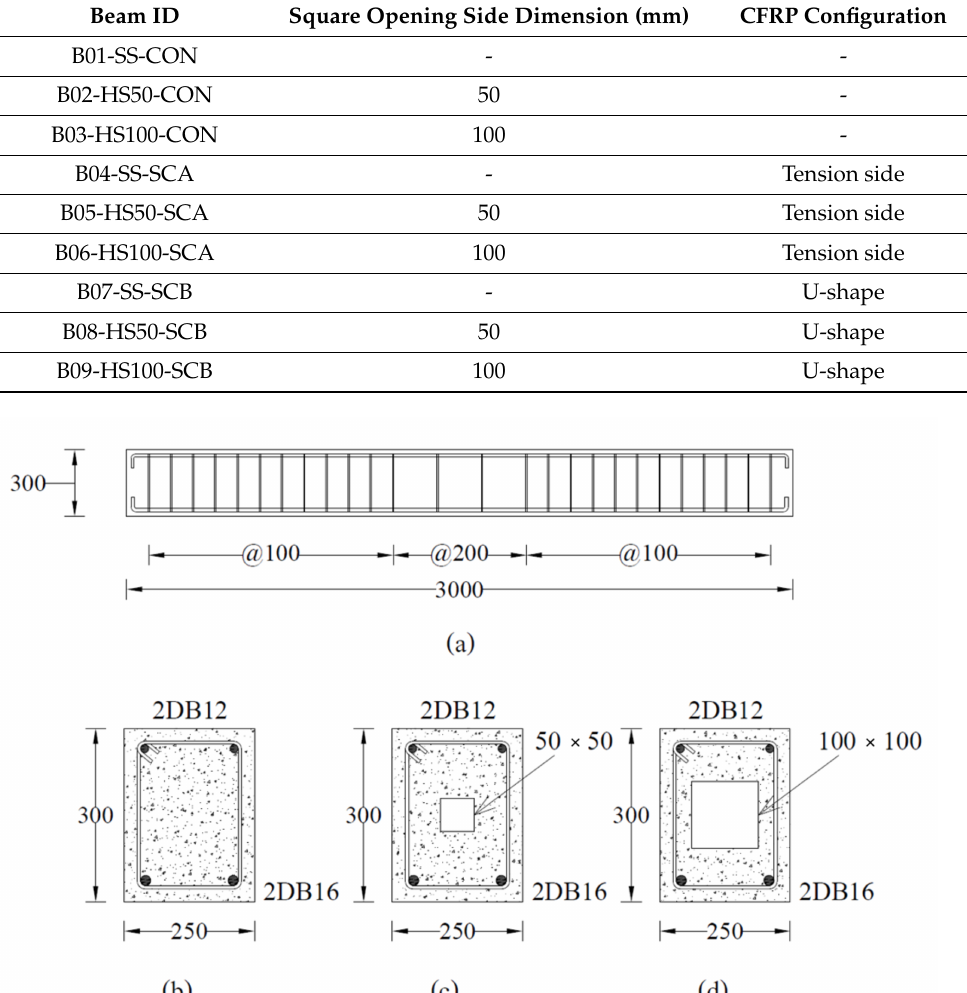
Table 1. Test matrix.